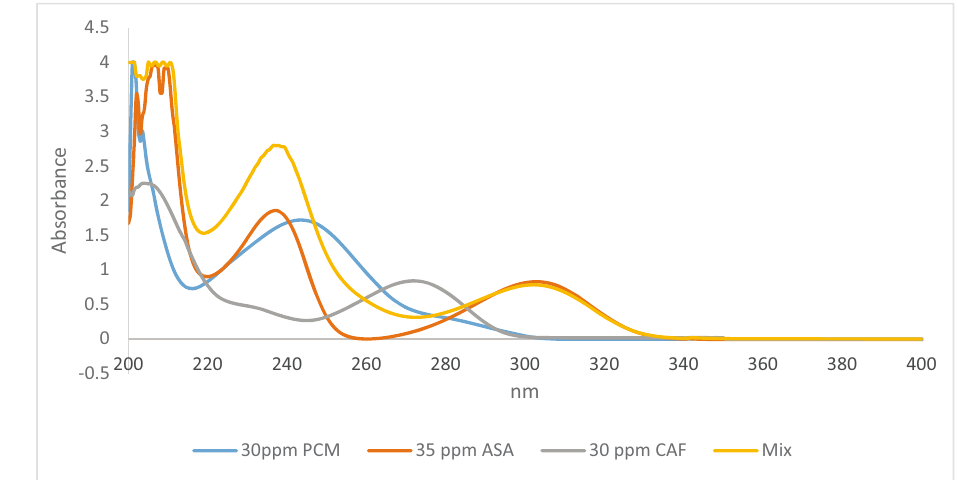
Figure 3: The absorption spectrum of ASA, PCM, ca ff eine